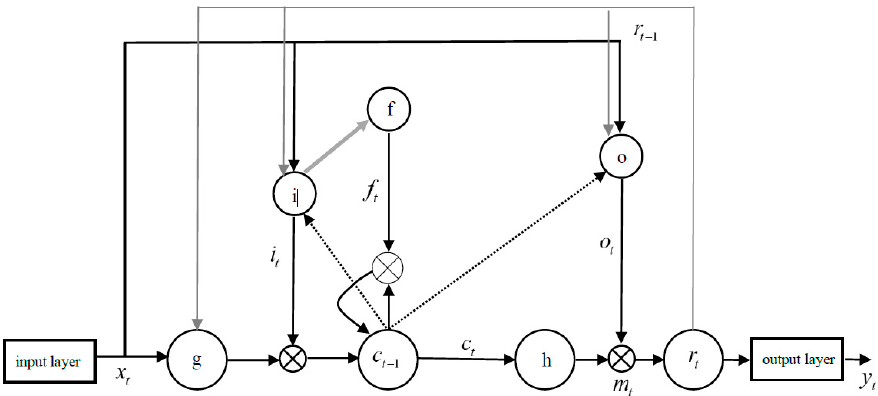
Figure 6. The binarized long short-term memory neural network.